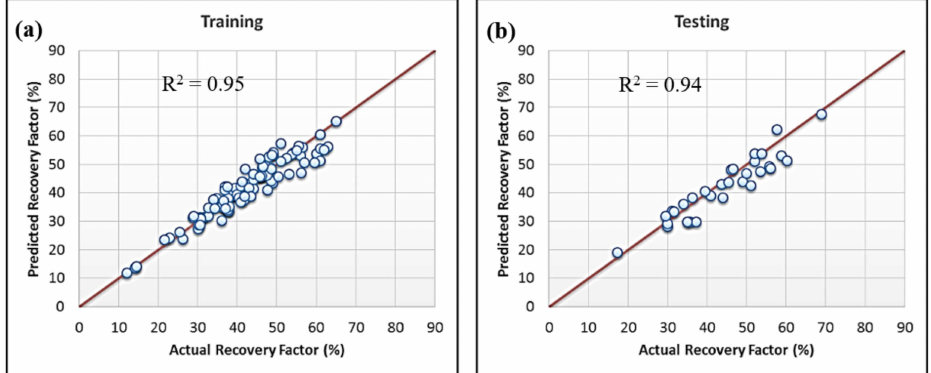
Figure 2. Predicted vs. actual RF based on the artificial neural network (ANN) model ( a ) training dataset, ( b ) testing